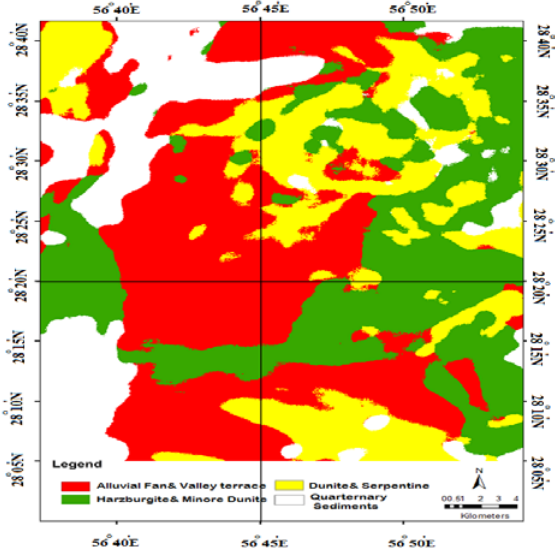
Figure 7. The SAM image map derived from Landsat TM data.